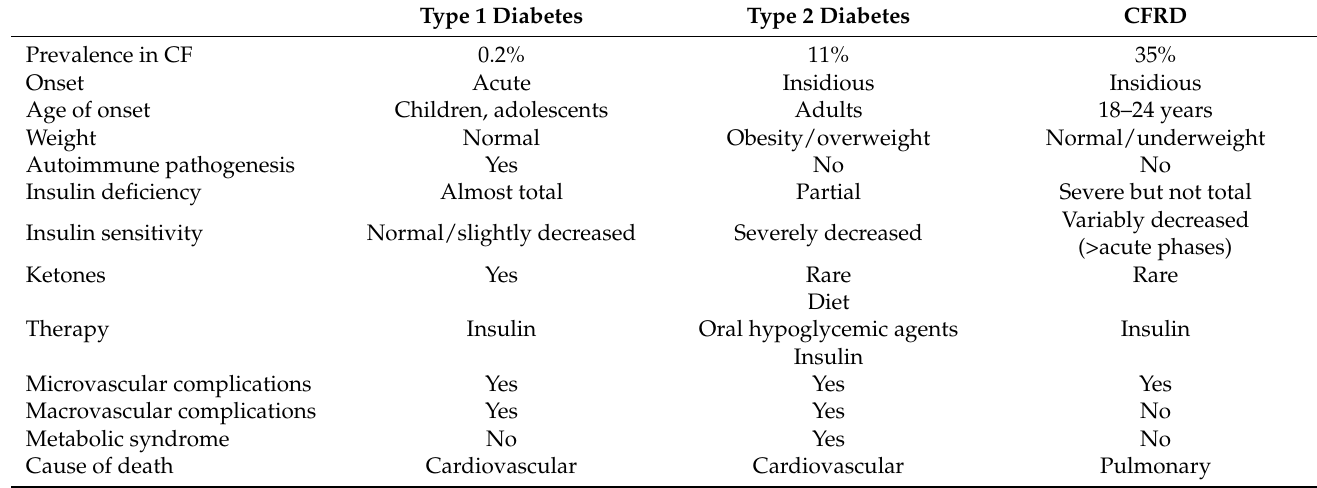
Table 1. Characteristics of the different forms of diabetes: type 1 diabetes, type 2 diabetes, and cystic fibrosis-related diabetes (CFRD). Adapted from Moran et al.